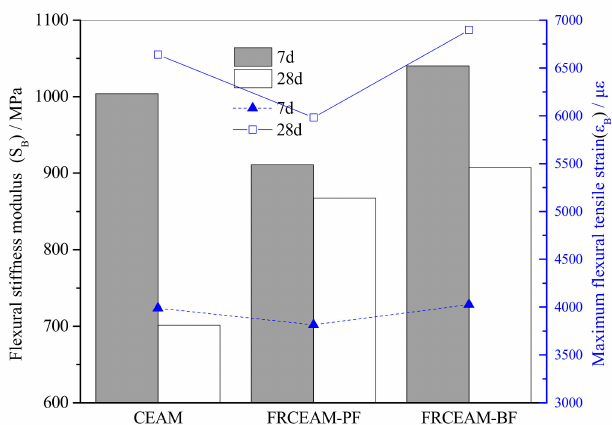
Figure 7. Maximum flexural tensile strains and flexural tensile stiffness modulus of CEAM and